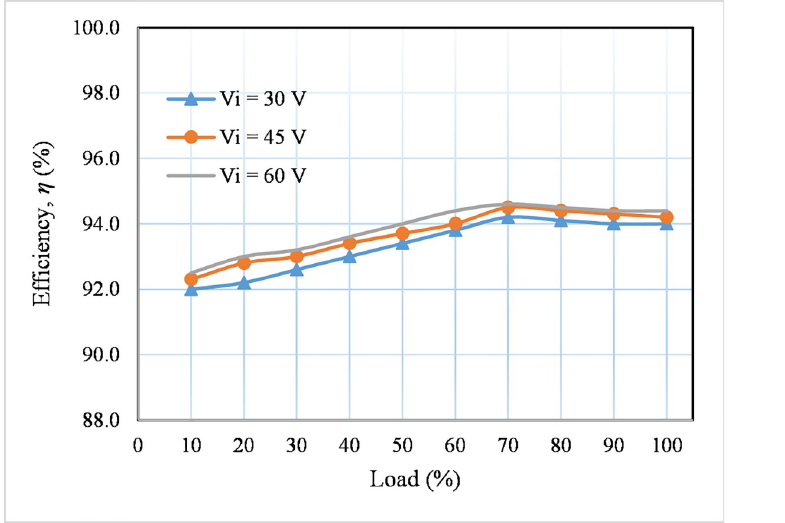
Fig 13. Measured efficiency for different input